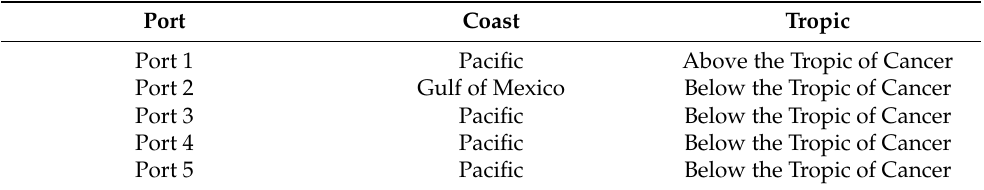
Table 1. Naming and location of ports.